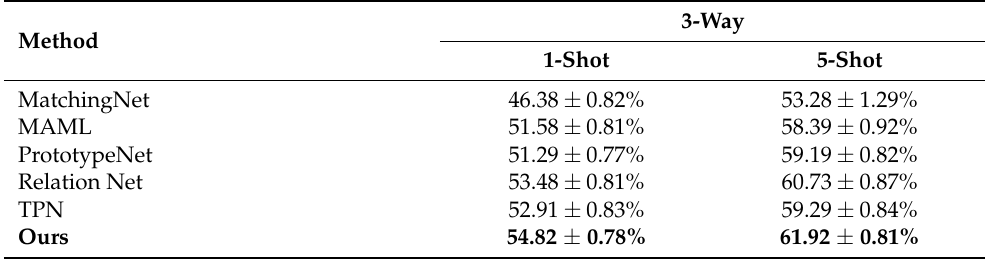
Table 3. The accuracy comparison of different methods on the PathMNIST dataset.